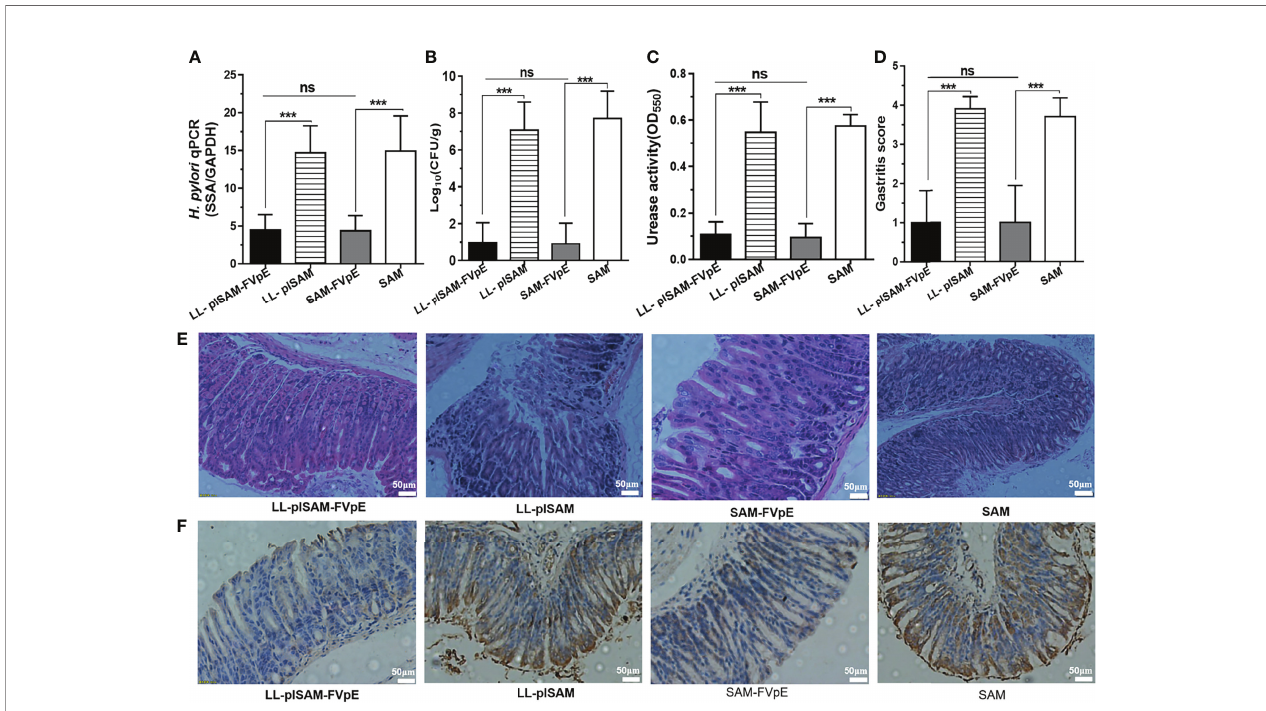
FIGURE 7 | The therapeutic effect of oral immunization with recombinant L. lactis vaccine LL-plSAM-FVpE. (A) qPCR. Data are expressed as the ratio of ( H ) pylori SSA gene to mouse GAPDH. ***p <0.001; ns: not signi fi cant. (B) Quantitative culture of bacteria. After therapeutic immunization, the amount of CFU in the mouse stomach was determined by quantitative culture of bacteria. ***p <0.001; ns: not signi fi cant. (C) Urease activity test. After therapeutic immunization, ( H ) pylori urease activity in the stomach of mice was examined by a rapid urease assay. ***p <0.001; ns: not signi fi cant. (D, E) Gastritis grading of gastric tissue and representative histopathology images. After therapeutic immunization, in fl ammation in the stomach of mice was evaluated by HE staining and gastritis grading. ***p <0.001; ns: not signi fi cant. (F) IHC analysis. The colonization of (H) pylori in the stomach of mice was examined by IHC